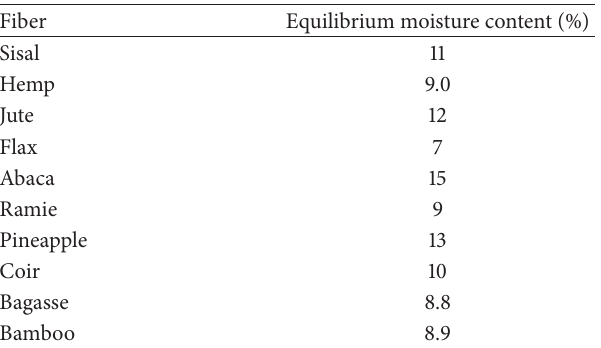
Table 4: The equilibrium moisture content of different natural fiber at 65% relative humidity (RH) and 21 ∘ C [4].